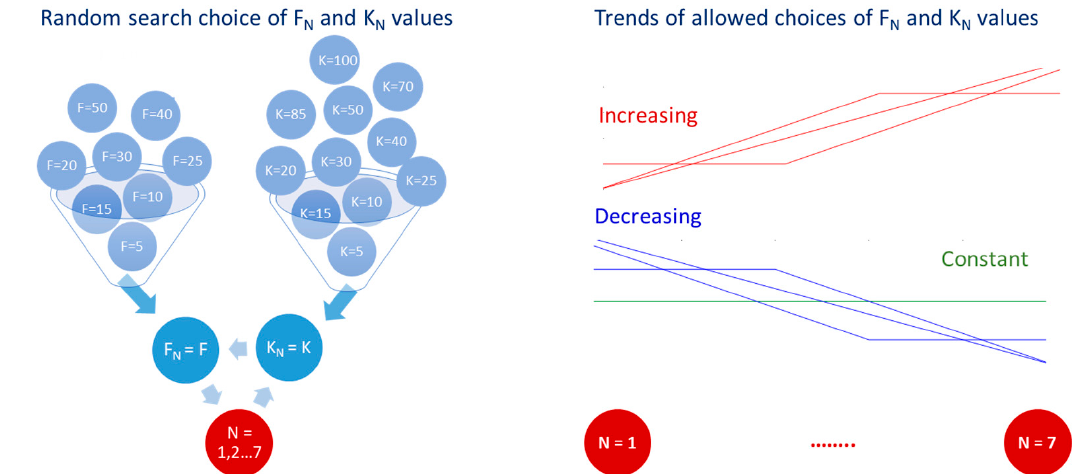
Figure 3. Random search choice of the hyperparameters HP = { N,F i ,K i } N : grid of values ( left ) and allowed trends of change from first to last CNN layer ( right ). The lines on the right correspond to the seven possible scenarios for driving F N and K N values over layers, i.e., constant (green), continuous increasing (red), constant+continuous increasing (red), continu- ous+constant increasing (red), continuous decreasing (blue), constant+continuous decreasing (blue), continuous+constant decreasing (blue).